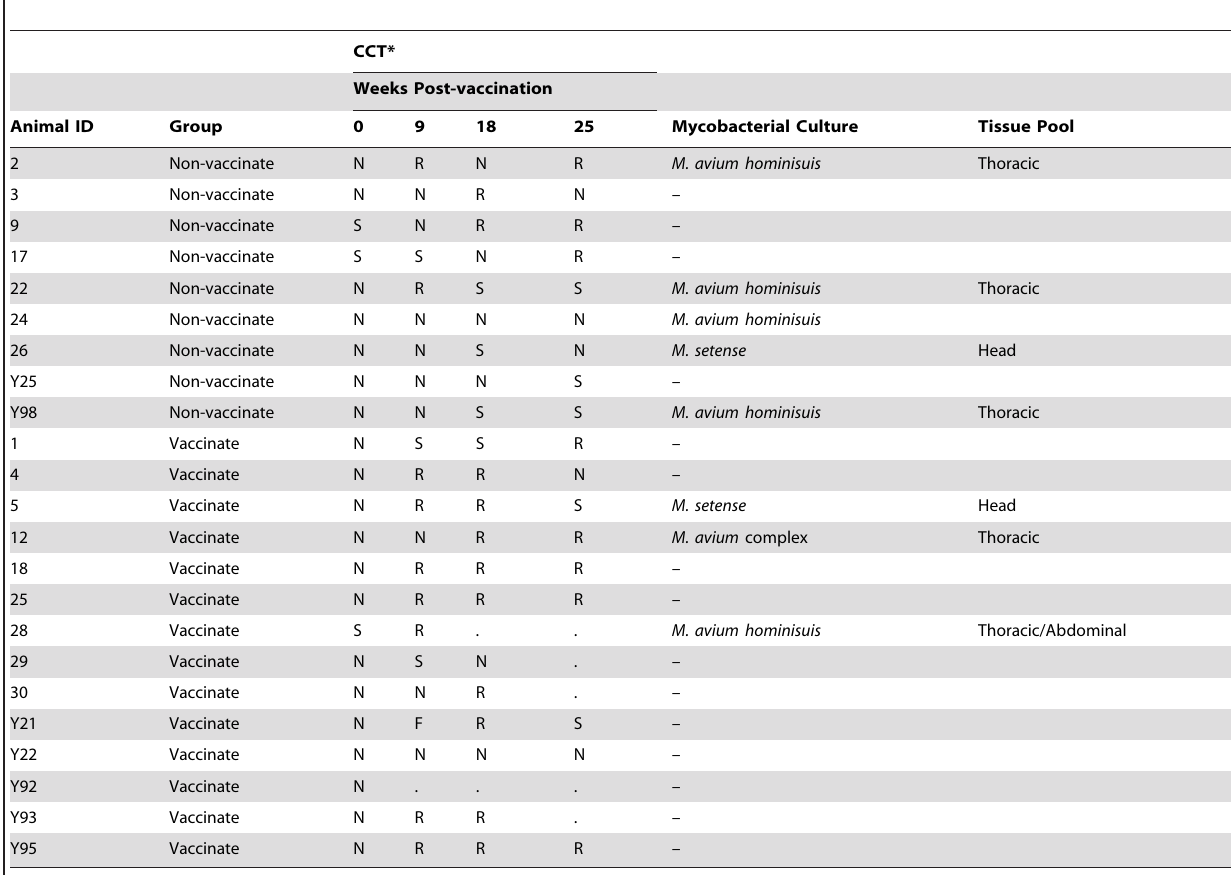
Table 1. Comparative cervical test (CCT) results in individual deer at each time point and outcomes of tissue culture at